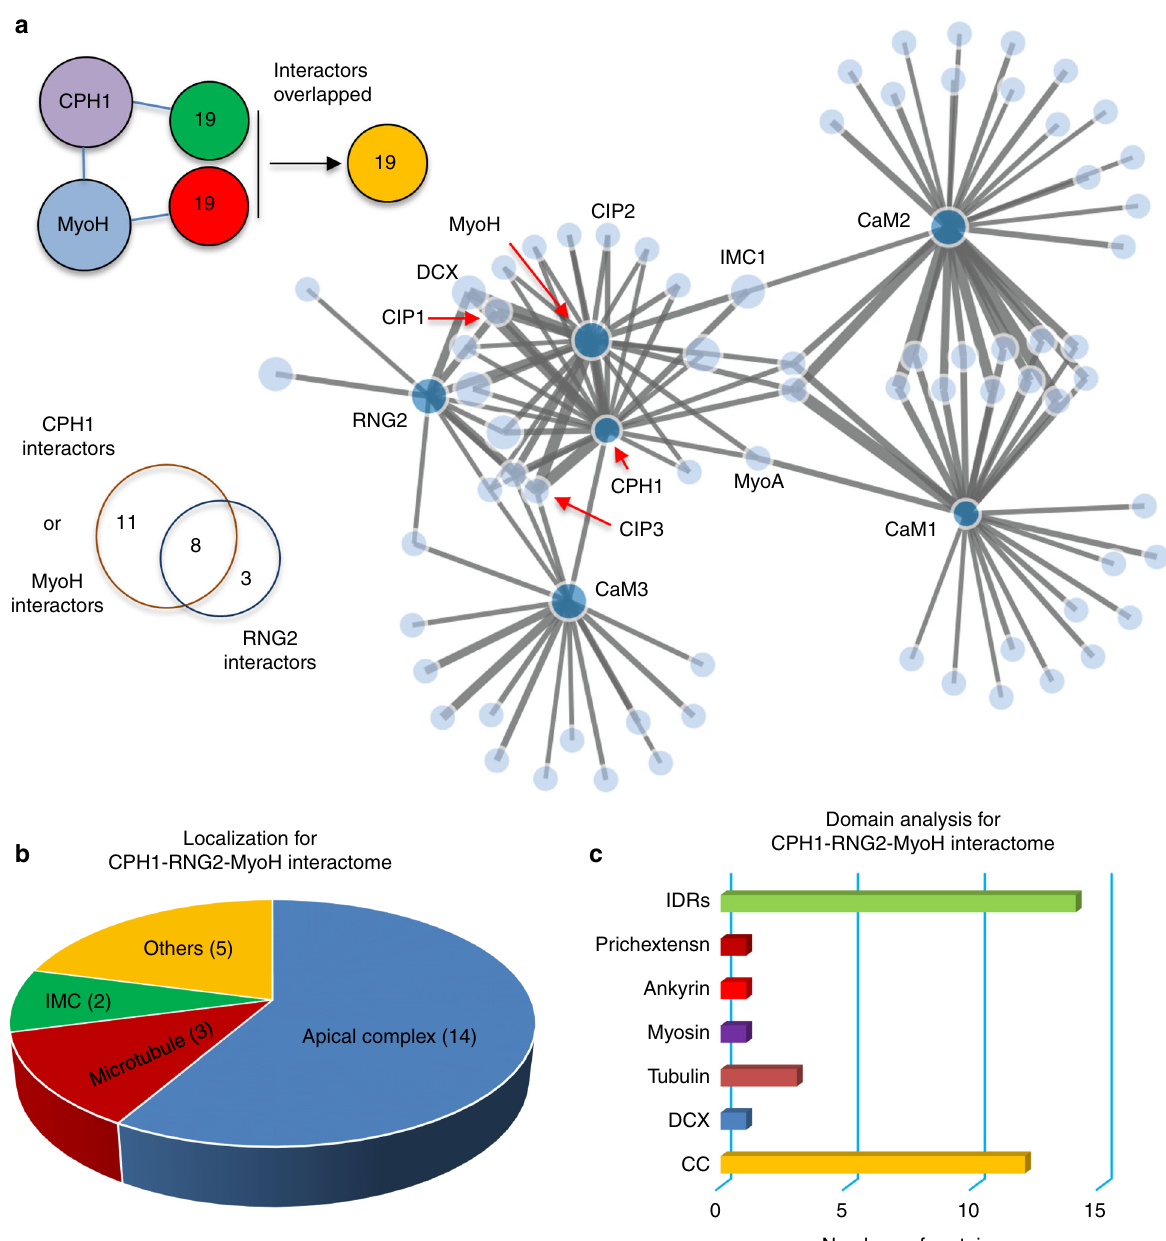
Fig. 5 CPH1 is a central hub interacting with multiple proteins at the conoid. a Replicate mass spectrometry data sets generated with BirA fusion lines were analyzed using SFINX (http://s fi nx.ugent.be/) to generate a proximity-based protein interaction network. Interactors of CPH1 and MyoH completely overlapped, and were partially shared with those for RNG2. Baits (BirA fusions) — deep blue nodes; prey (interactors) — light blue nodes. See Supplementary Data 2. b Localizations for the CPH1-MyoH-RNG2 interactome were analyzed for annotated and hypothetical proteins identi fi ed in the CPH1-MyoH-RNG2 interactome. Pie chart shows percentages of each category. The number in each category indicates protein number. N = 24 interactors. c Domains were analyzed for apical proteins and microtubule in the CPH1-MyoH-RNG2 interactome with InterPro. N = 17 interactors. b , c Protein localizations and domains for proteins in the CPH1-MyoH-RNG2 interactome were determined as de fi ned in Supplementary Data 2. See also Supplementary Data 4, 5 and Supplementary Fig. 5 for GO term analysis. CC coiled coil, DCX double cortin microtubule-binding domain, myosin myosin A and H, prichextensin proline- rich motif present in plant cell wall, IDRs intrinsically disordered